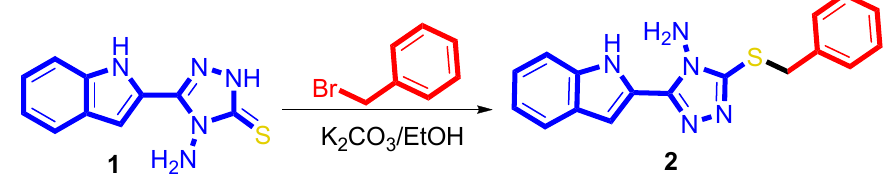
Table 1. Crystal and refinements data of 2 .